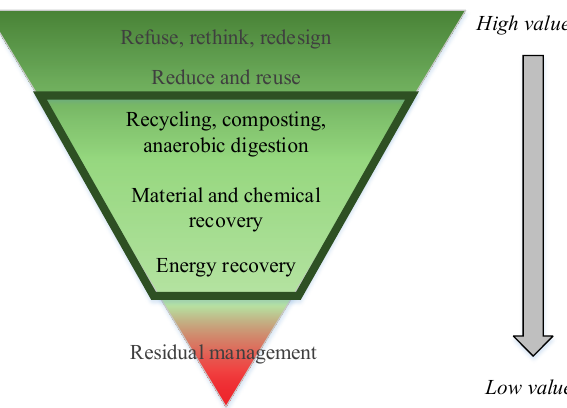
Fig. 2. Waste management hierarchy (Authors’ illustration adapted from [34]).